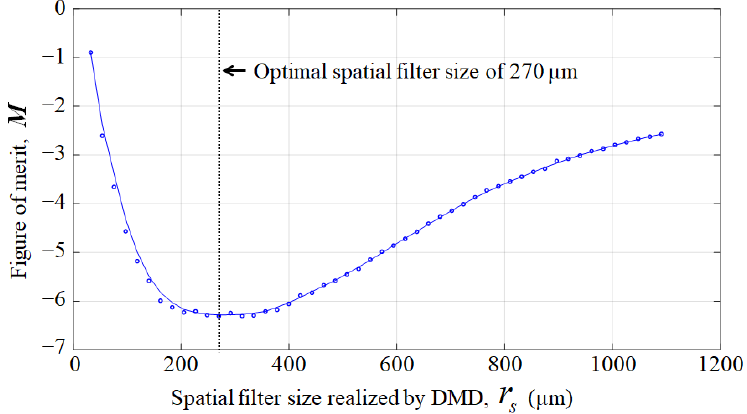
Figure 11. Optimal spatial filter size realized by DMD in experimental configuration.